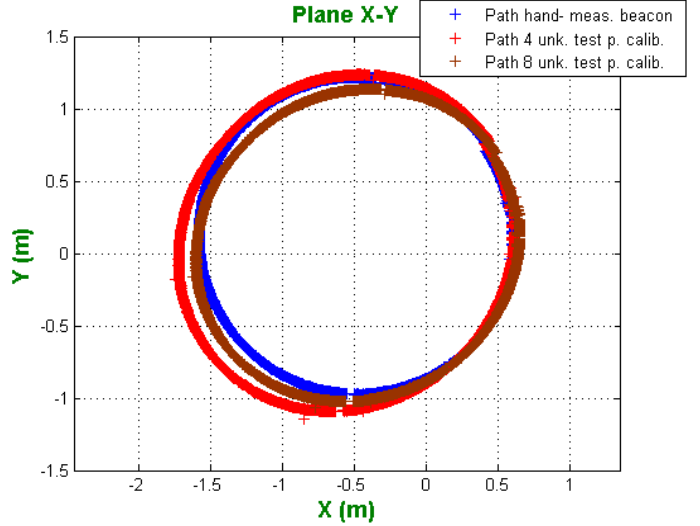
Figure 12. Path obtained using the hand-measured beacon positions and the calibrated beacons (hyperbolic